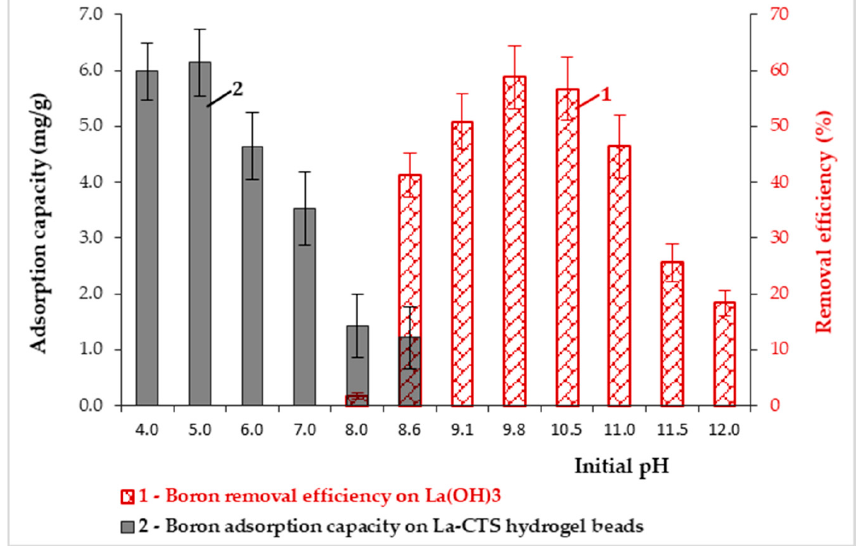
Figure 7. Boron removal efficiency on La(OH) 3 ( graph 1) and boron adsorption capacity on La-CTS beads (graph 2) as a function of initial pH value at temperature of 20 ± 1 °C.